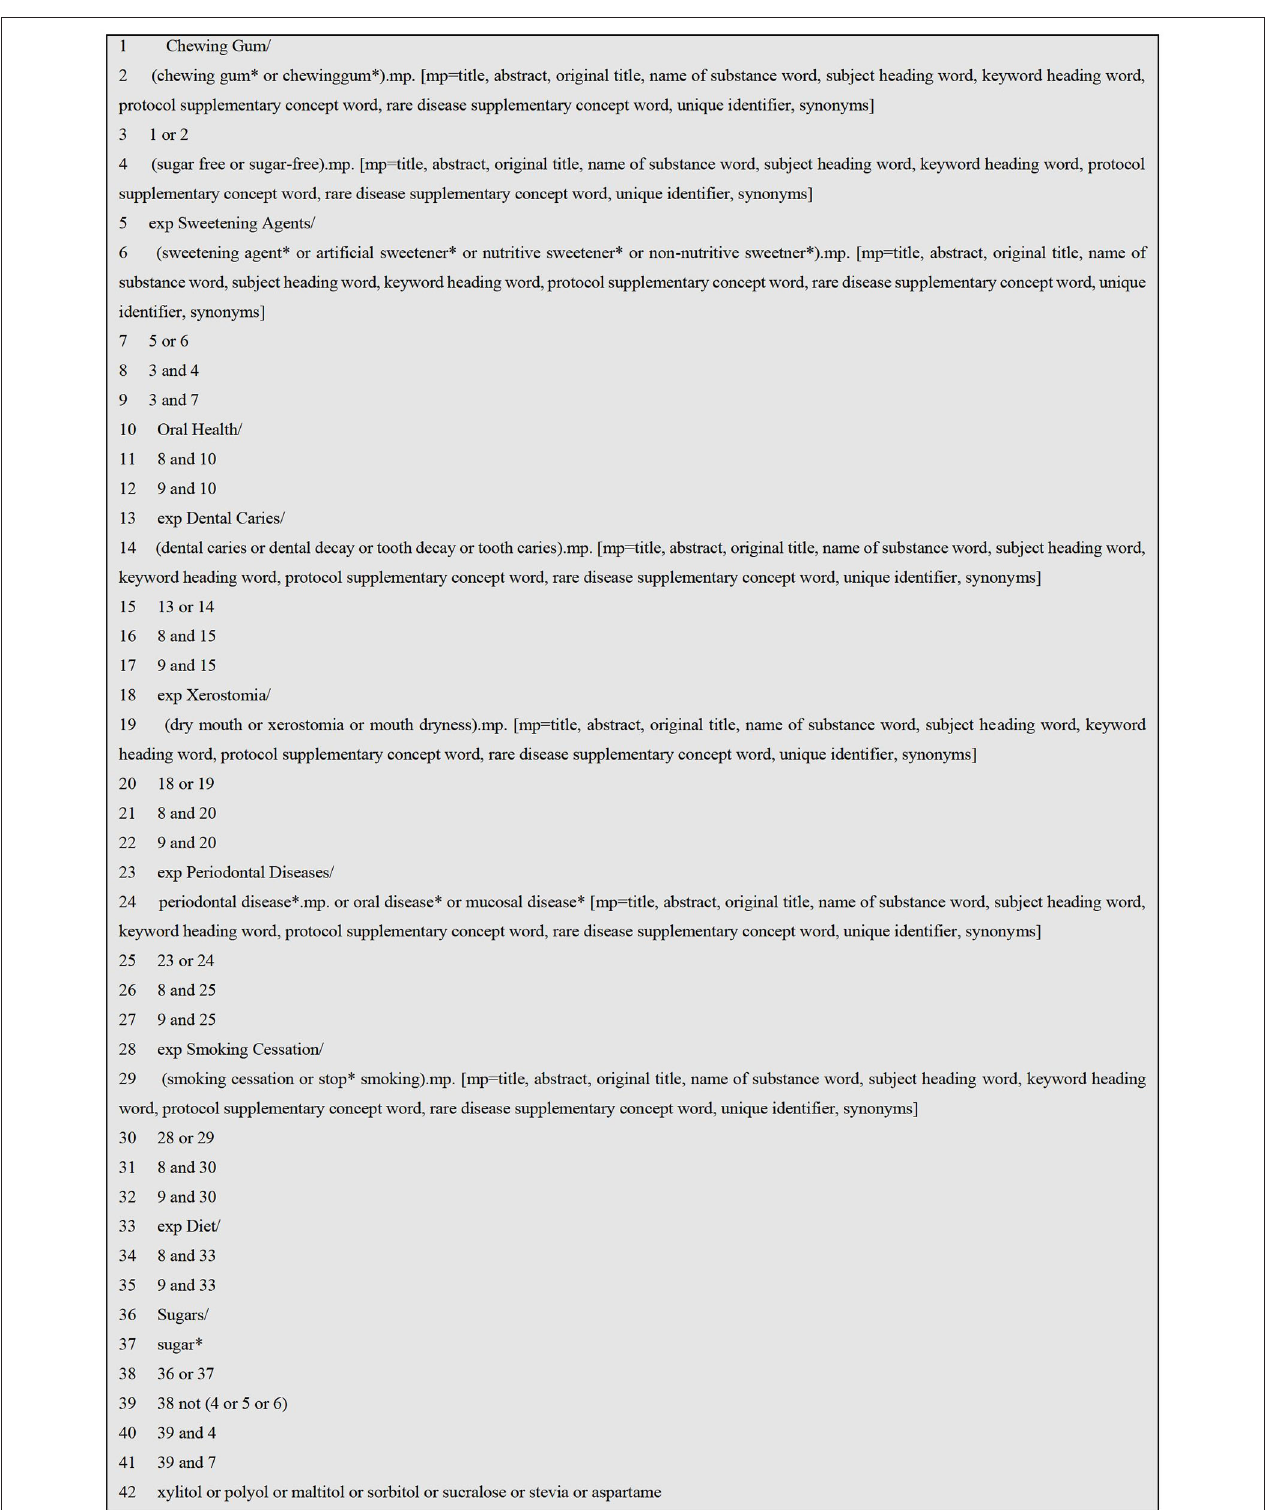
FIGURE 1 | Search Strategy for Ovid Medline, modified for other databases.